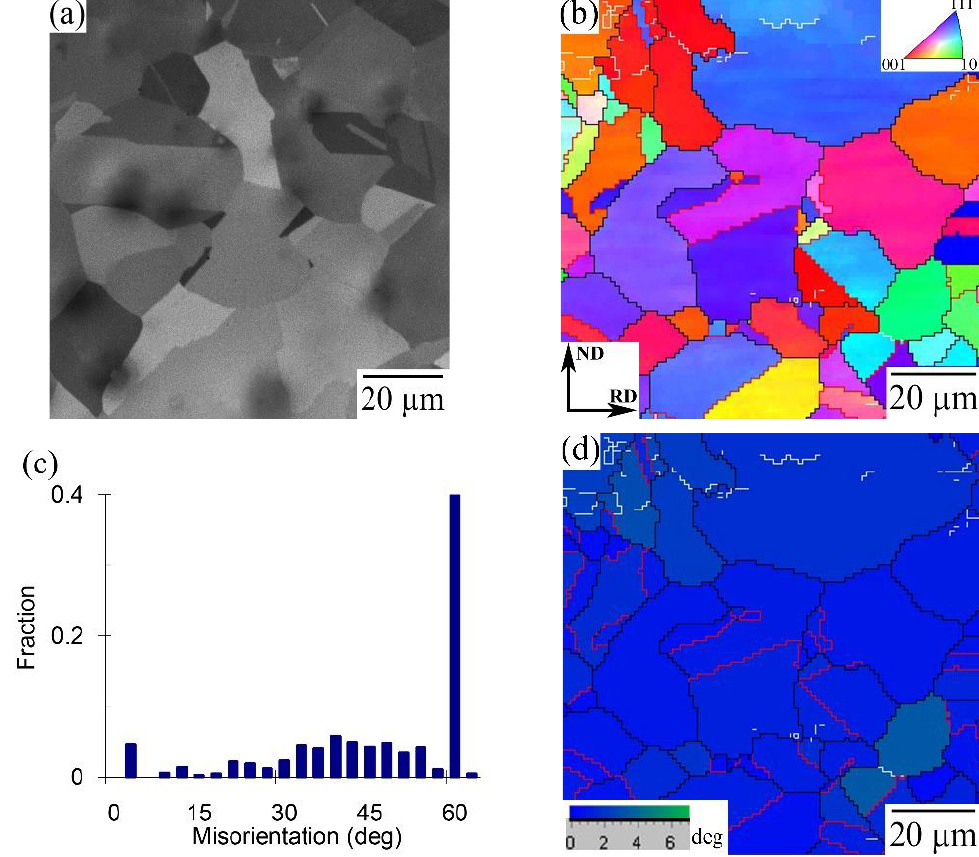
Figure 1. Microstructure in the cross-section of the initial sheet of Ni before USC: ( a ) backscattered electron (BSE) image; ( b ) crystal orientation map (COM) with color code in right top corner; ( c ) distribution of grain boundary misorientation angles; and ( d ) grain average misorientation map with the color code in the lower-left angle.